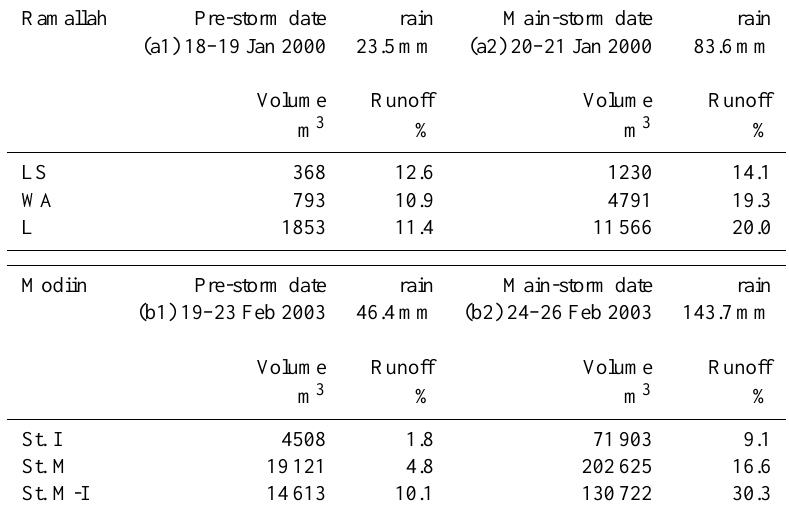
Table 5. Runoff response during two high-magnitude events: Ramallah (a1–a2) and Modiin (b1–b2). Ramallah